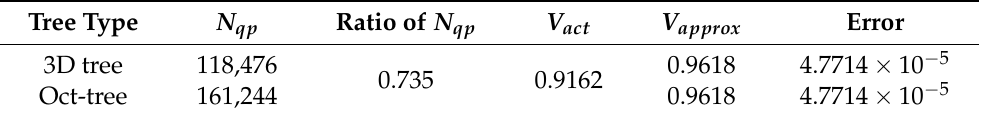
Table 9. Comparison of kd-tree and oct-tree cell division for quadrature cell refinement in the presence of multiple inclusions with hyper-spherical boundary (shown in Figure 24b).